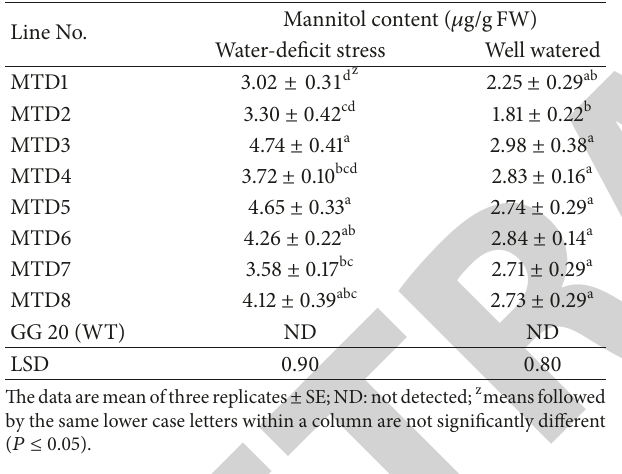
Table 3: Effect of imposing water-deficit stress on 45-day-old plants (T and WT) after 24 days of stress imposition on mannitol content. Line